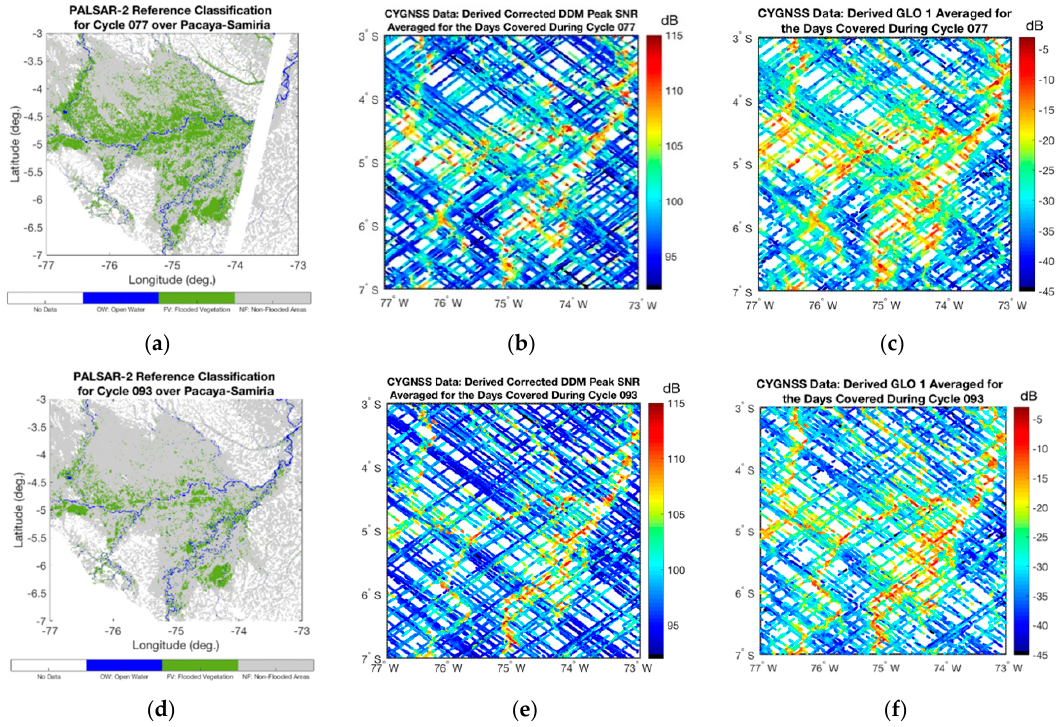
Figure 5. Seasonal comparison. Left column shows two examples of the modified PALSAR-2-based reference inundation classification maps for ( a ) the end of the high-flood season during cycle 77, and ( d ) the end of the low-flood season during cycle 93. Center column shows the same seasonal comparison for the CYGNSS observable corrected peak SNR during ( b ) cycle 77 and ( e ) cycle 93. Right column shows the seasonal comparison for the CYGNSS observable GLO 1 during ( c ) cycle 77 and ( f ) cycle 93. Plots ( b , c , e , f ) are in logarithmic scale (dB). All of the analysis was done at the first Fresnel zone gridded at 500 m × 500 m. For display purposes only, this Figure shows the CYGNSS observables at approximately 3 km.